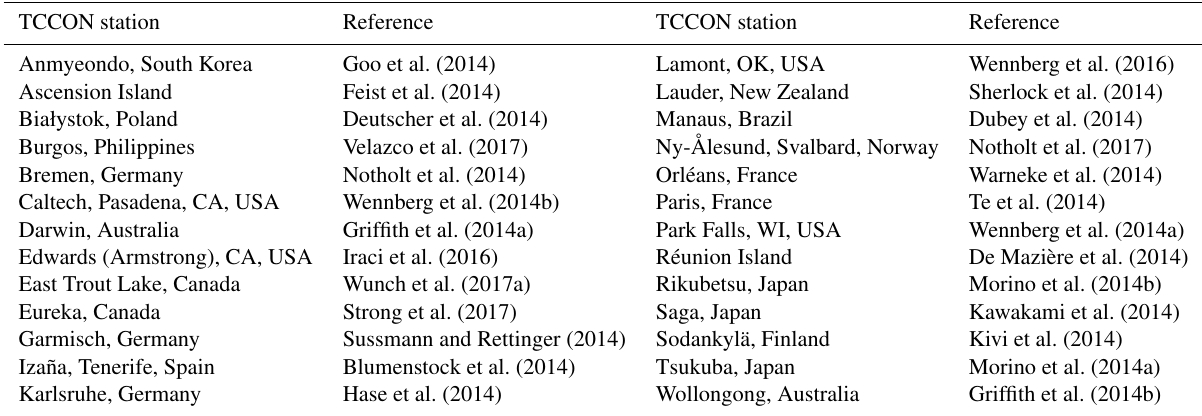
Table 6. Stations used in the TCCON truth proxy data